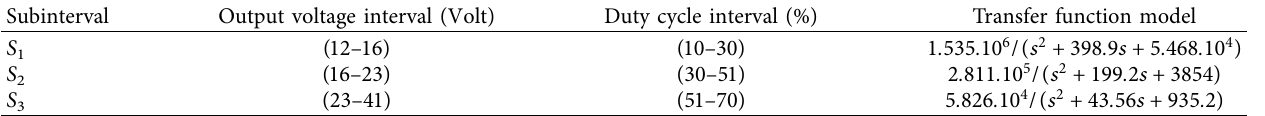
Table 3: Transfer function model corresponding to each subinterval ( S